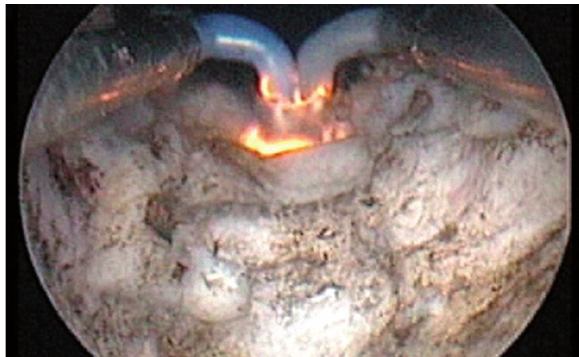
Figure 3 - At the end of the procedure and cavity